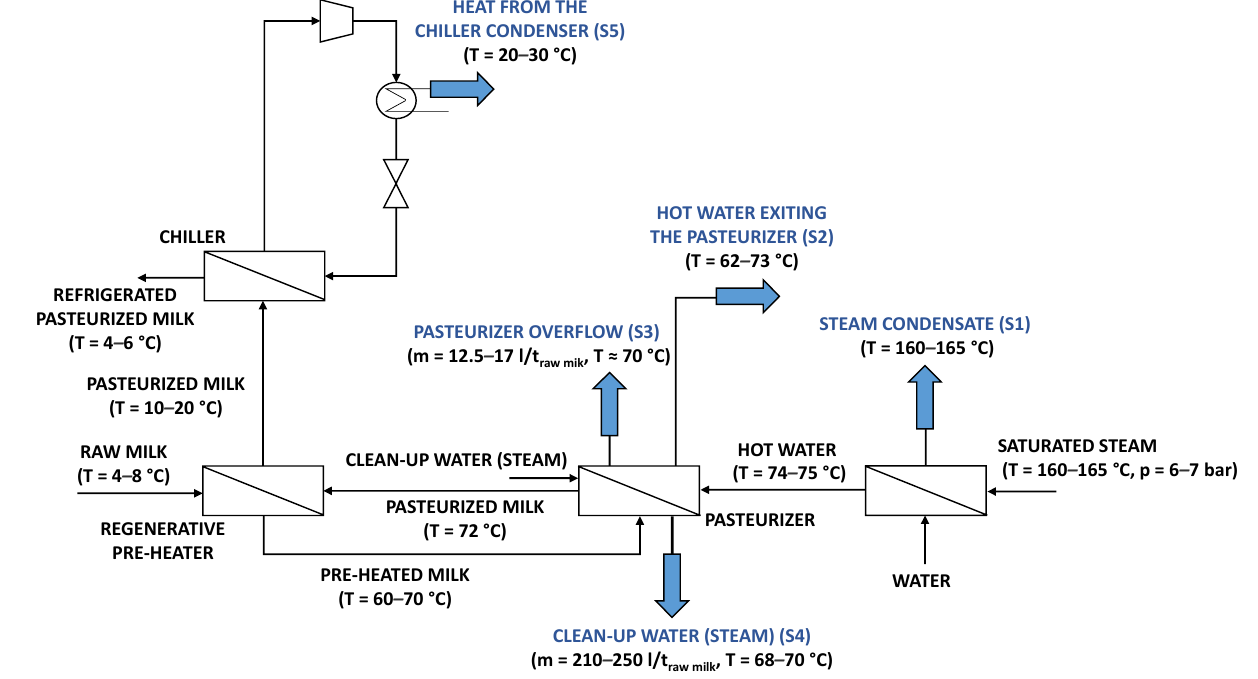
Figure 3. Scheme of low-temperature waste heat sources in pasteurized milk processing (from authors’ elaboration).